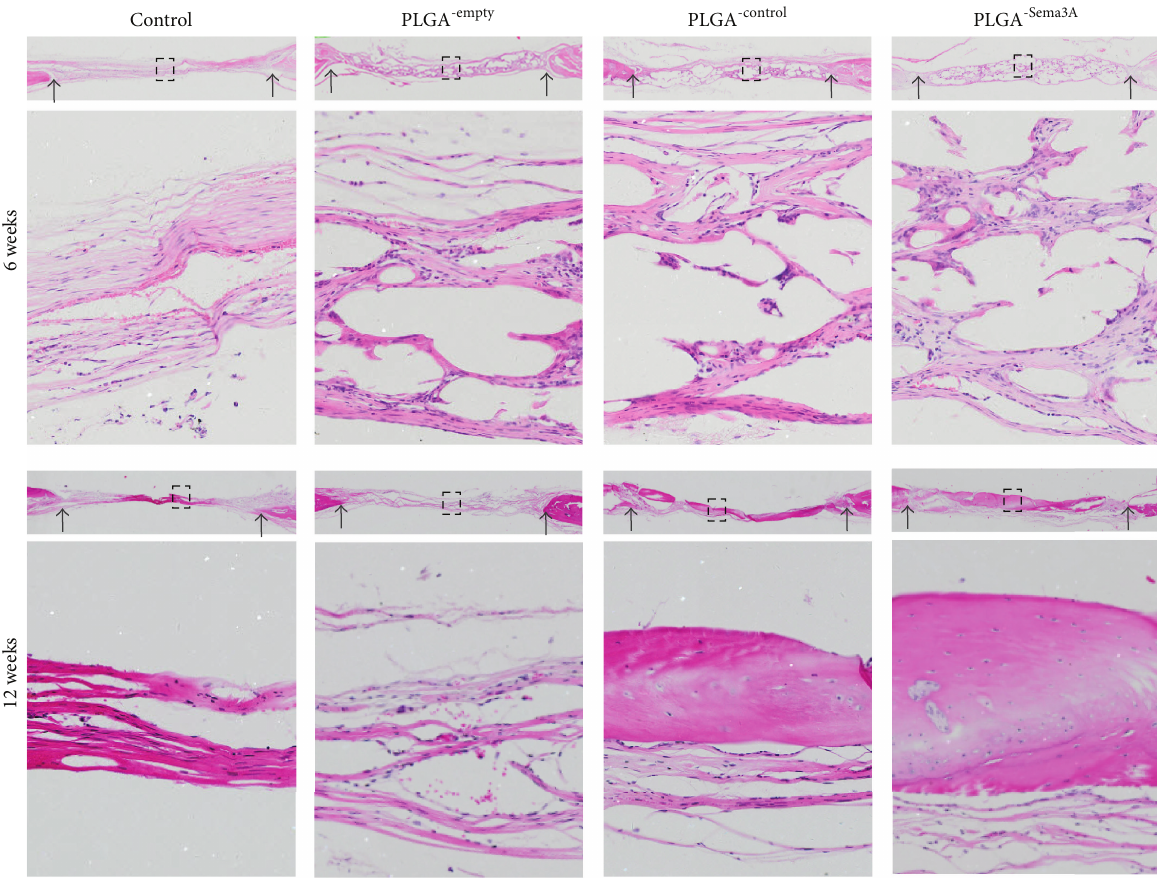
Figure 6: ASC - Sema 3 A engrafted PLGA scaffold increases bone repair in the calvarial defect model. Bone regeneration of calvarial defects evaluated by HE staining. Control indicates that defects received nothing; PLGA - empty , PLGA - control , and PLGA - Sema 3 A indicate that defects implanted with ASC, ASC - control , and ASC - Sema 3 A , respectively. Data presented are representative HE staining images from 5 different experiments. Black arrows point to the defect margins, and the lower panels are the magnifications of the insets in each